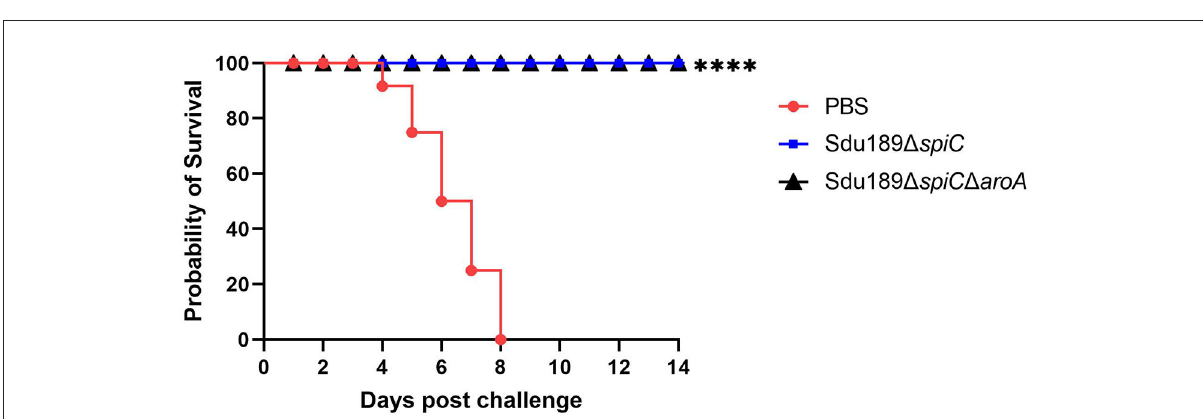
FIGURE6 Protective efficiency of two vaccine candidates in balb/c mouse. * p < 0.05, ** p < 0.01, *** p < 0.001 and **** p < 0.0001 compared with the survival number of mice of control group mice by one-way ANOVA followed by Bonferroni’s multiple comparison